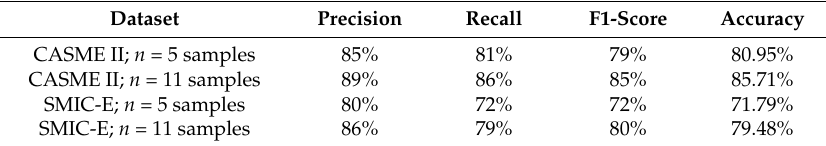
Table 3. Recognition performance on the CASME II and SMIC-E datasets.